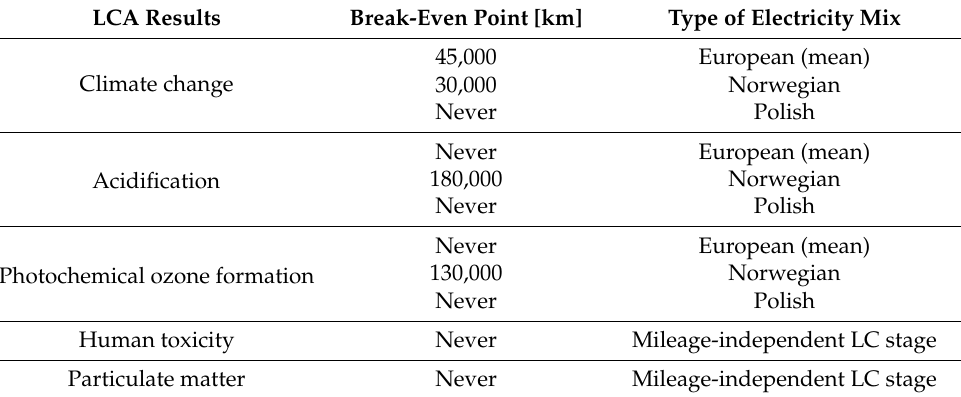
Table 1. Resume of the break-even points for the practical environmental convenience of electric car (Data source [9])—Mileage considered for LCA: 150,000